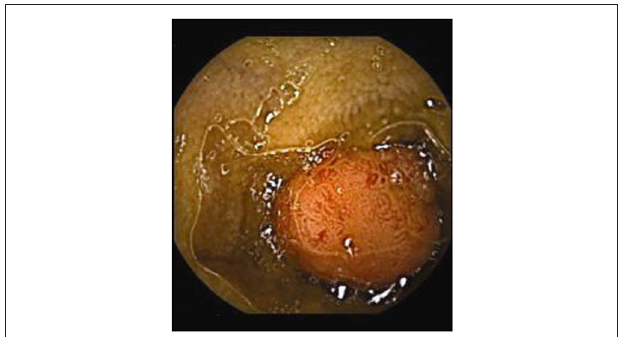
FIGURE 1 | Polyp in the